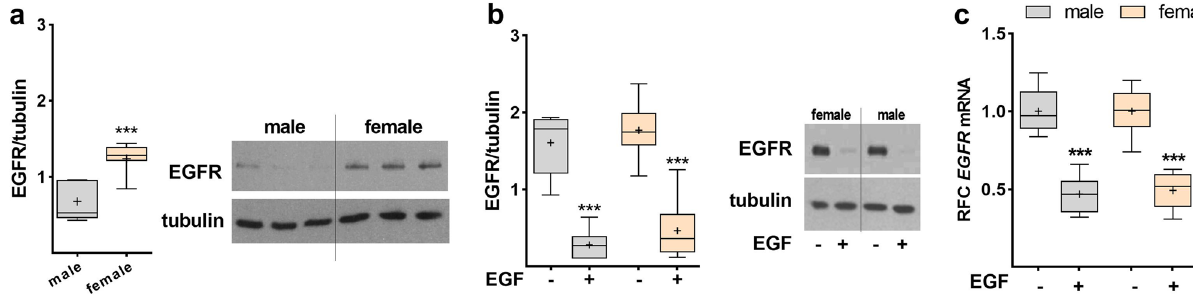
Figure 4. Sex-specific and EGF-dependent expression of EGFR. Data are displayed as box and whiskers with the 10–90 percentile, mean (+) and median (horizontal line). ( a ) EGFR protein expression was significantly higher in female FDLE cells compared to male cells in the presence of serum (n = 7; *** p < 0.001 by t -test). EGF application to FDLE cells cultured in SF-Med reduced EGFR protein ( b ) and mRNA expression ( c ) after 24 h in FDLE cells of both sexes (n = 6/8; *** p < 0.001 by t -test). (Grey boxes) male; (yellow boxes) Acute effects of EGF in sex‑specific FDLE cells.